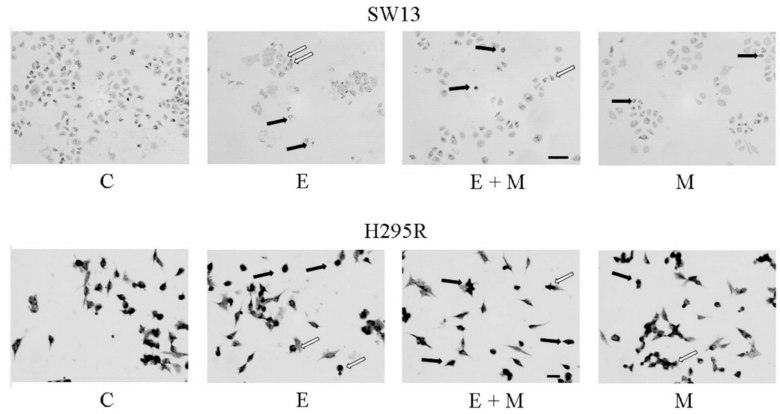
Figure 5. Cell morphology evaluated by Wright’s staining method after treatment with EF24, mitotane, and their combination in SW13 and H295R cells treated at 24 h and 72 h, respectively. The arrows show apoptotic (white) or necrotic cells (black). (C = control, E = EF24, M = mitotane, E + M = EF24 +